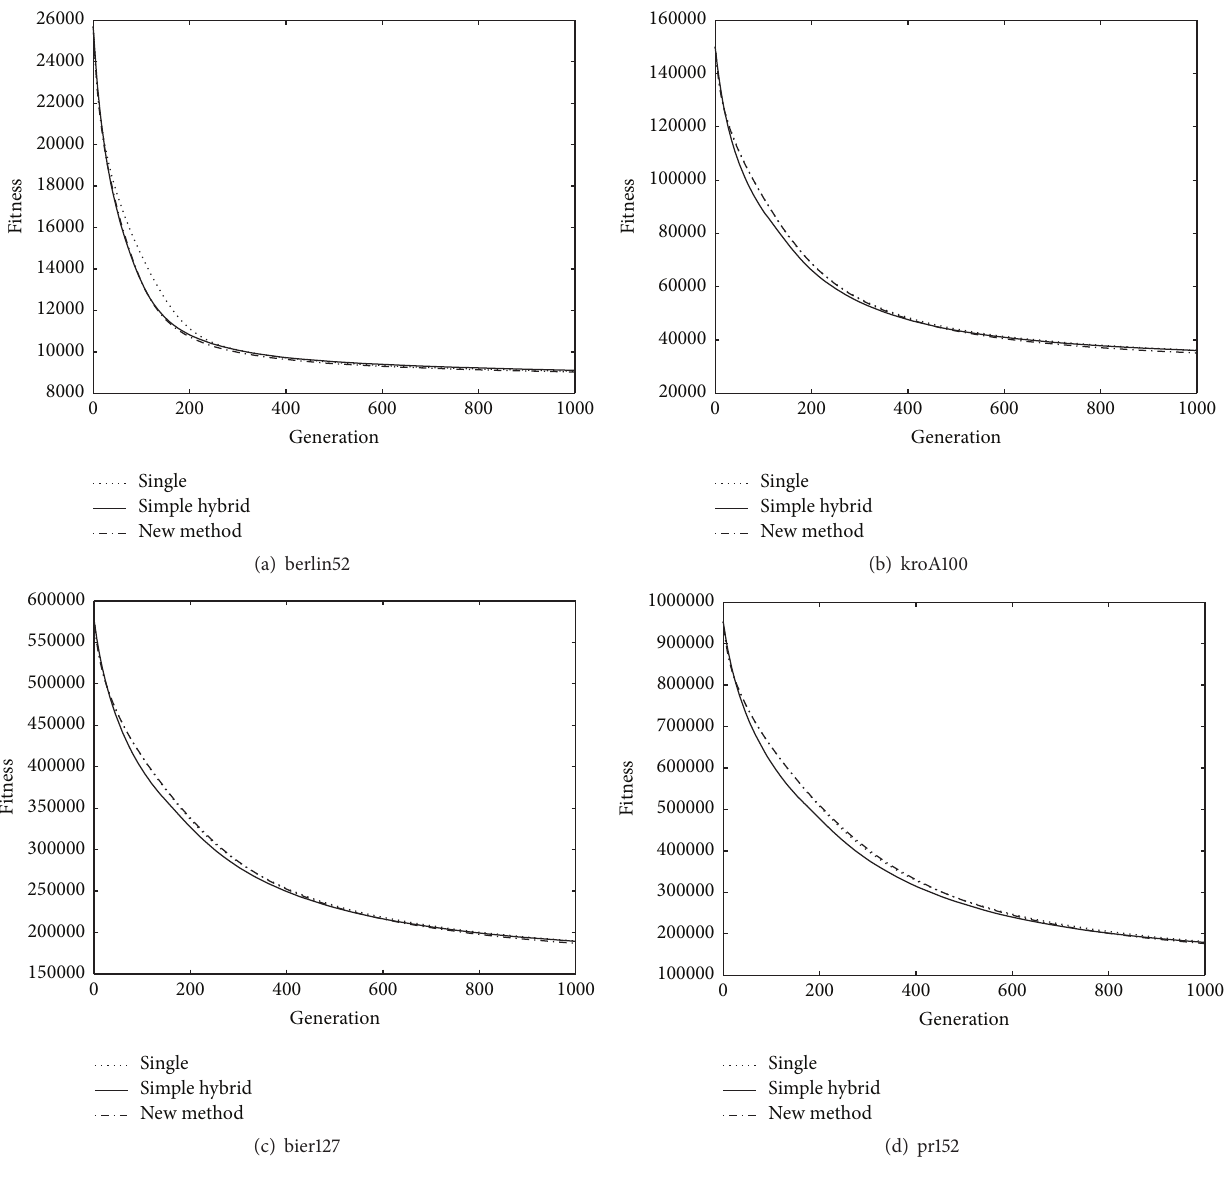
Figure 3: Fitness of mating schemes in TSP (the smaller, the